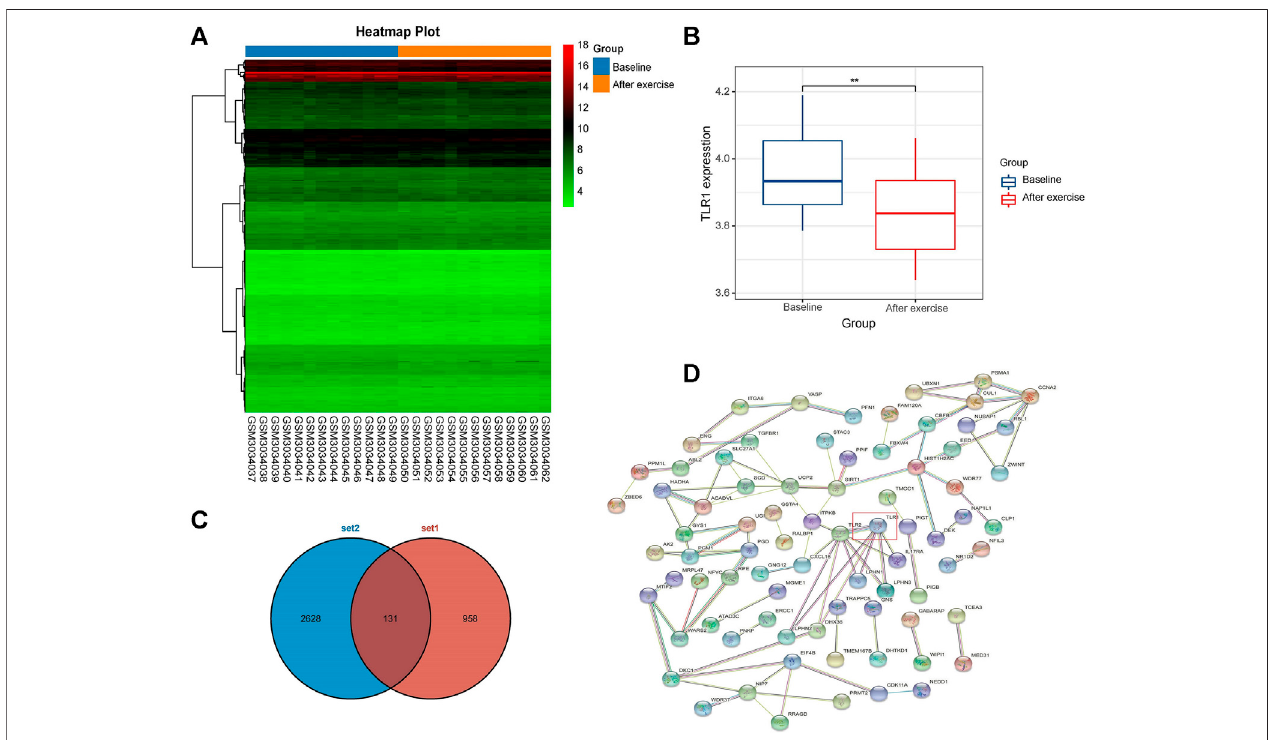
FIGURE 2 | (A) DEGs hierarchical cluster analysis between baseline and post training groups in GSE111551 database. 958 DEGs related to exercise were identi fi ed. Red, up-regulated genes, blue, down-regulated genes (B) The expression of TLR1 in exercise group (C) Venn map of two gene sets (D) 131 exercise-related DEGs were included in PPI network. The nodes indicated proteins. The edges represented protein ’ s